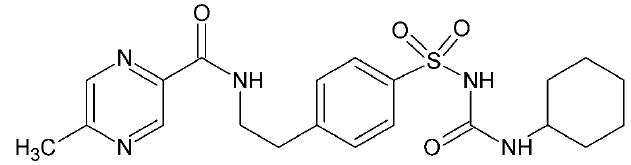
Figure 1. Glipizide molecular structure.